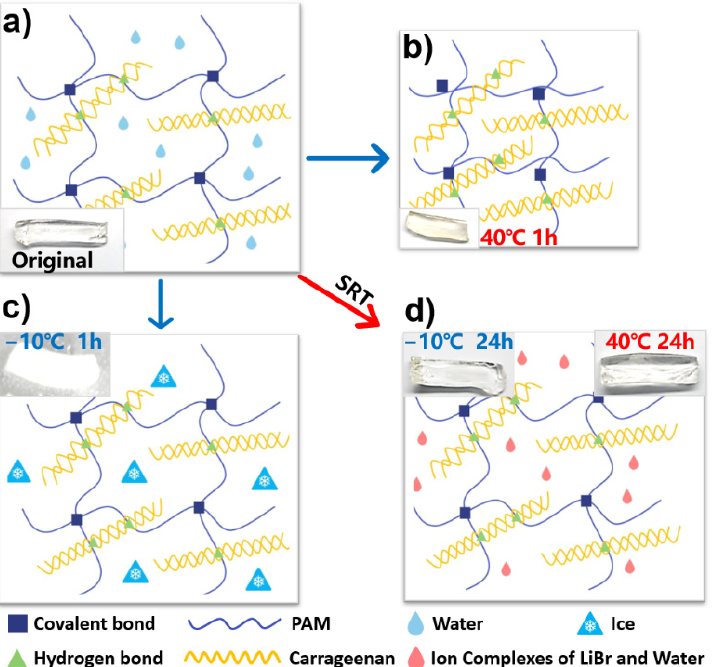
Figure 2. ( a ) Schematic illustration of the double ‐ networked (DN) hydrogel without solvent replacement treatment (SRT) at original state. Inset is the photograph of the original hydrogel; ( b , c ) Dehydration and freeze state of the original DN hydrogel when stored at 40 °C and − 10 °C for 1 h; ( d ) Anti ‐ freezing and anti ‐ drying properties of DN hydrogel after SRT.